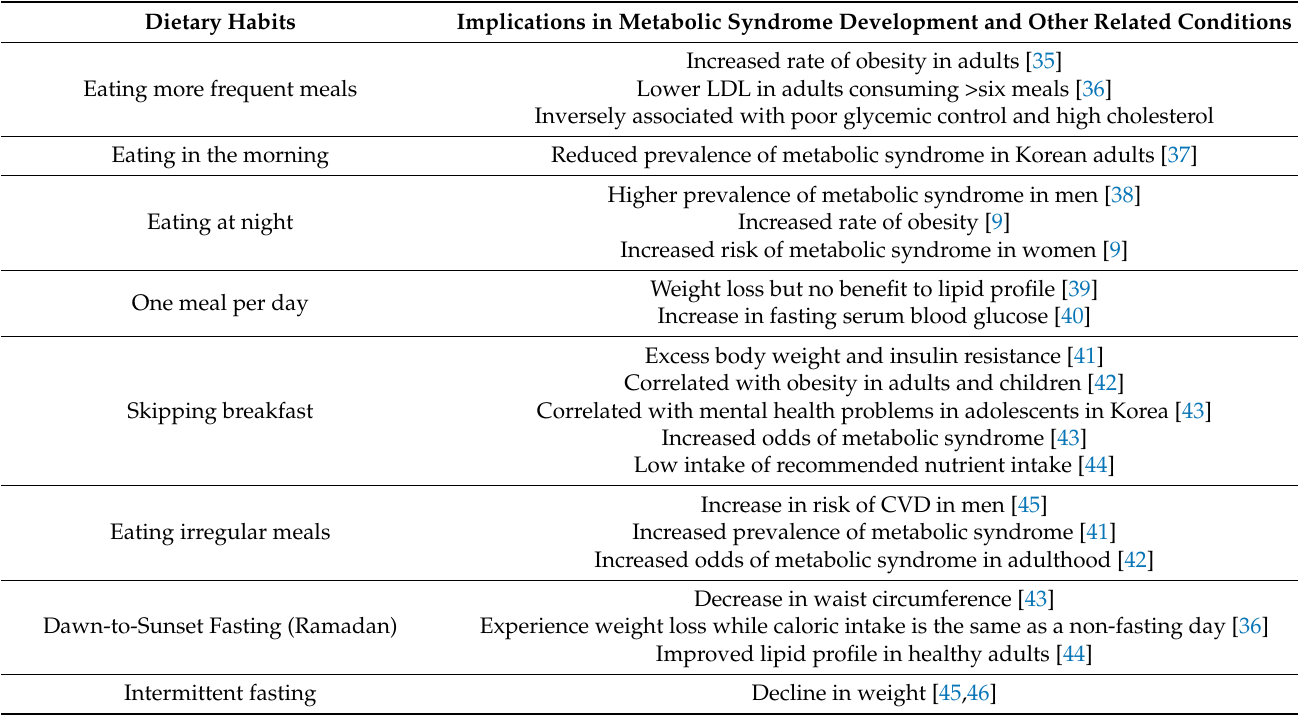
Table 1. Dietary habits and development of metabolic syndrome and other related